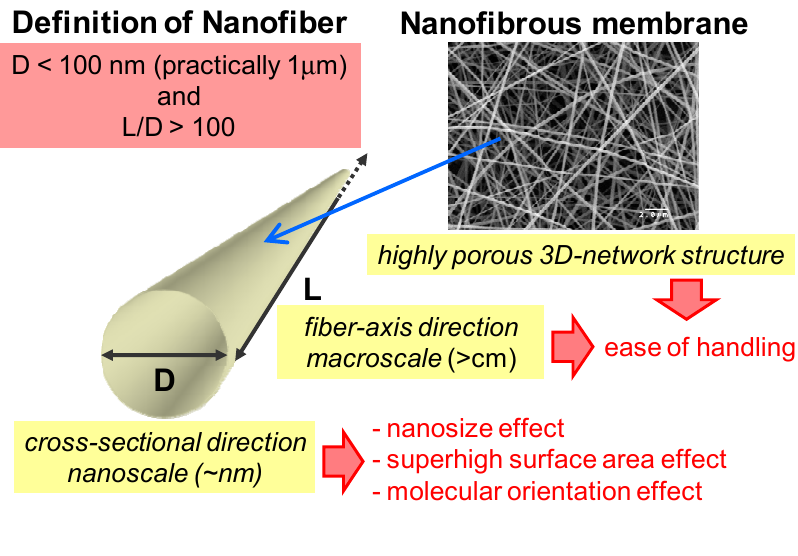
Figure 1. Characteristics of nanofiber and nanofibrous